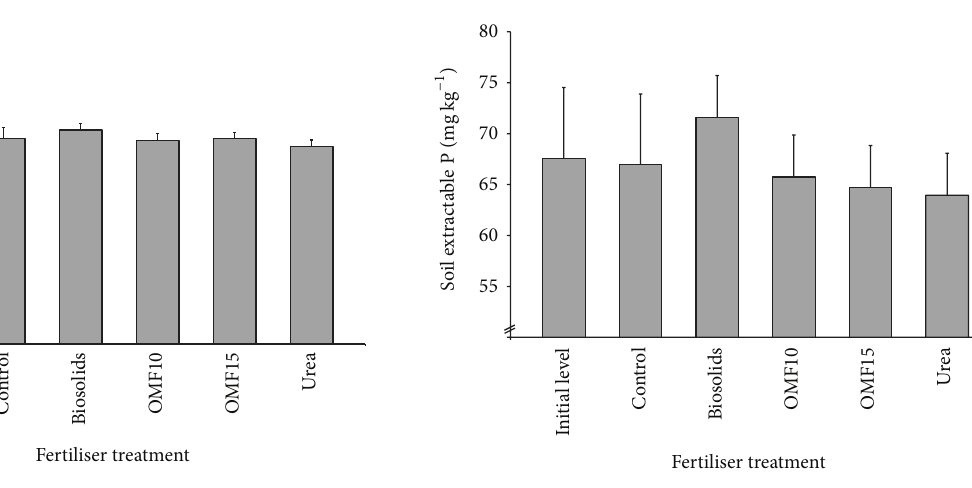
Figure 3: Mean total N in soil over the range of fertiliser application rates used in the experiment. The initial level corresponds to the baseline level prior to the start of the experiment. Use 𝑛 = 14 except for initial level and control 𝑛 = 3 ; 𝑃 = 0.06 (control versus treatments), 𝑃 = 0.91 (treatments). The error bars show the LSD value at 5% level.